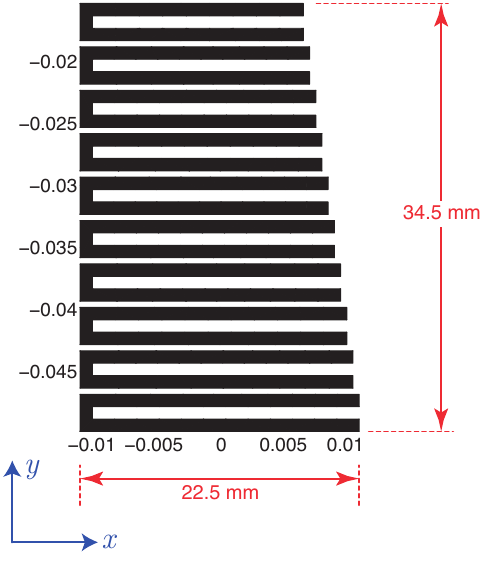
Figure 1: Single RFID tag structure that involves 10 res- onators, each corresponding to a bit.